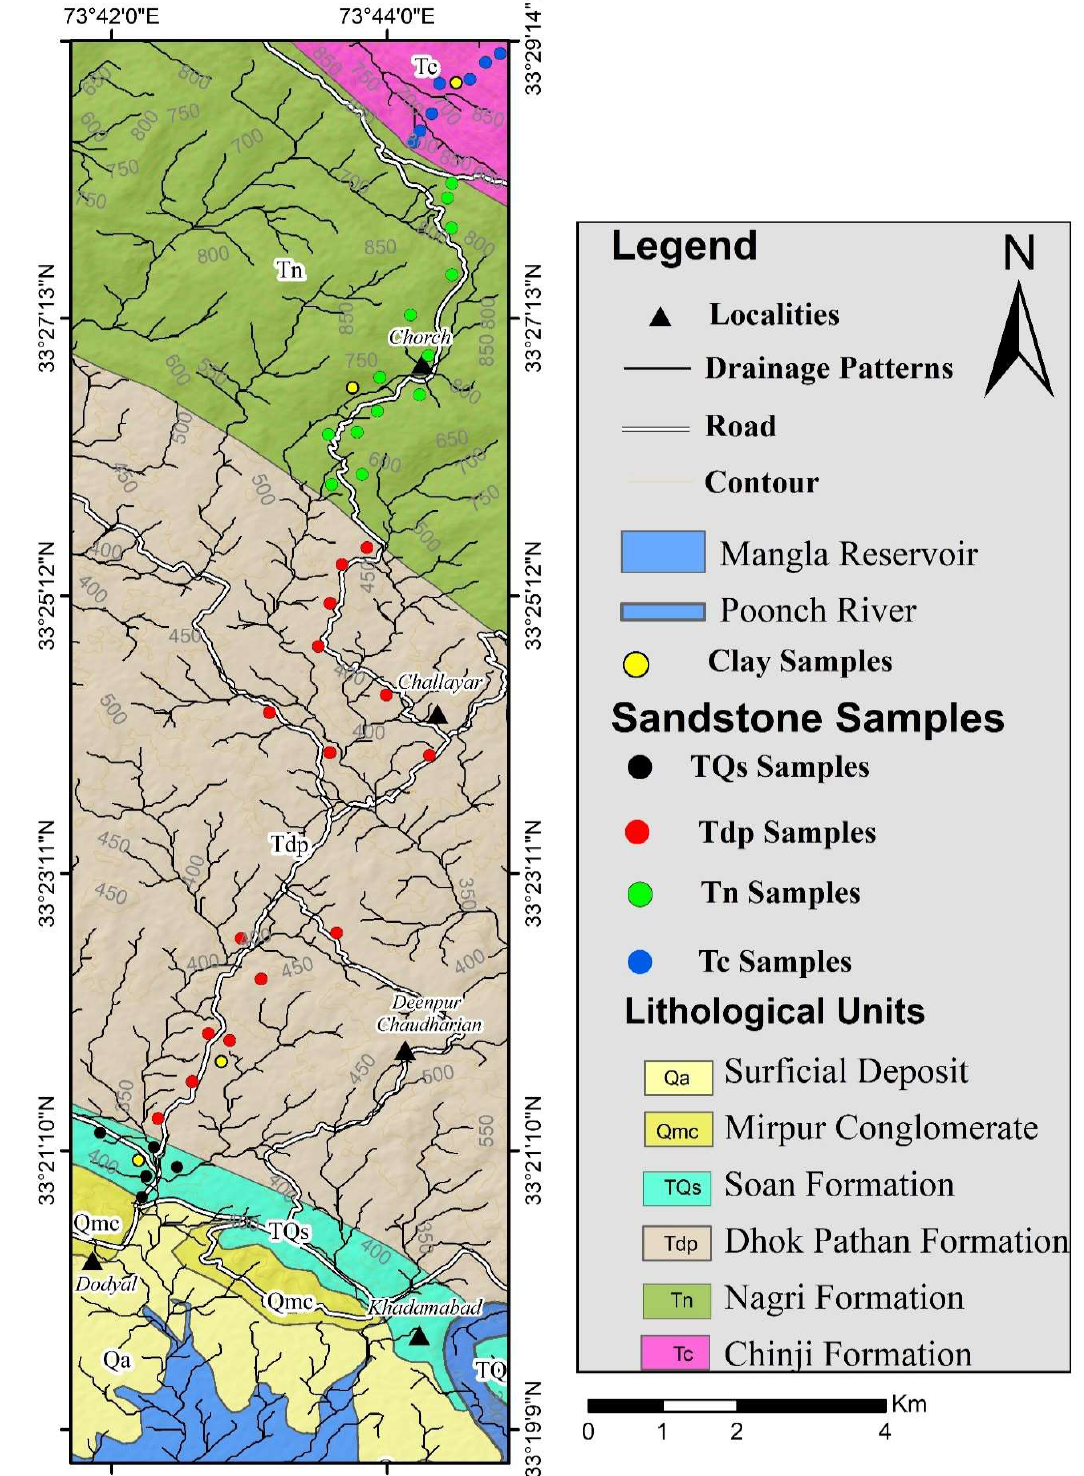
Figure 3. Geological and sample location map of the Siwalik Group in the southwestern region of the core of HKS (Dadyal to Sehnsa section).